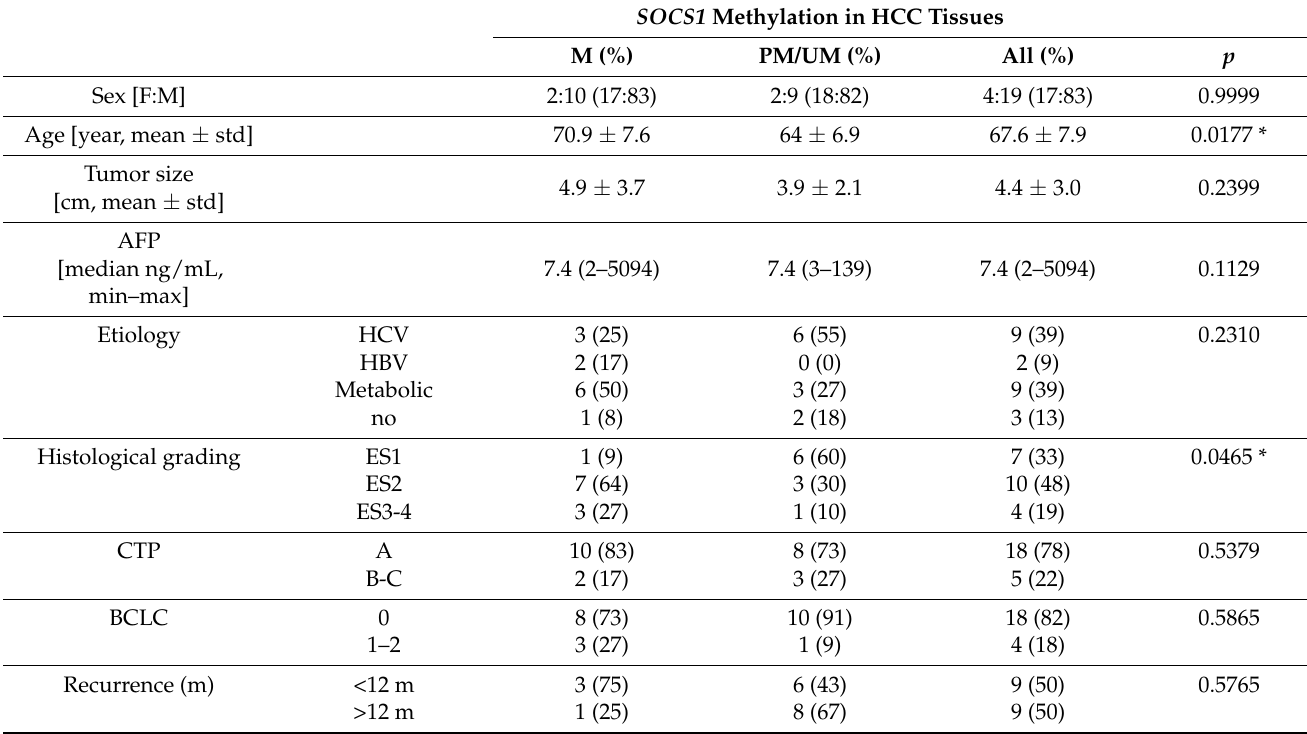
Table 2. The association between SOCS1 methylation with clinical parameters. SOCS1 Methylation in HCC